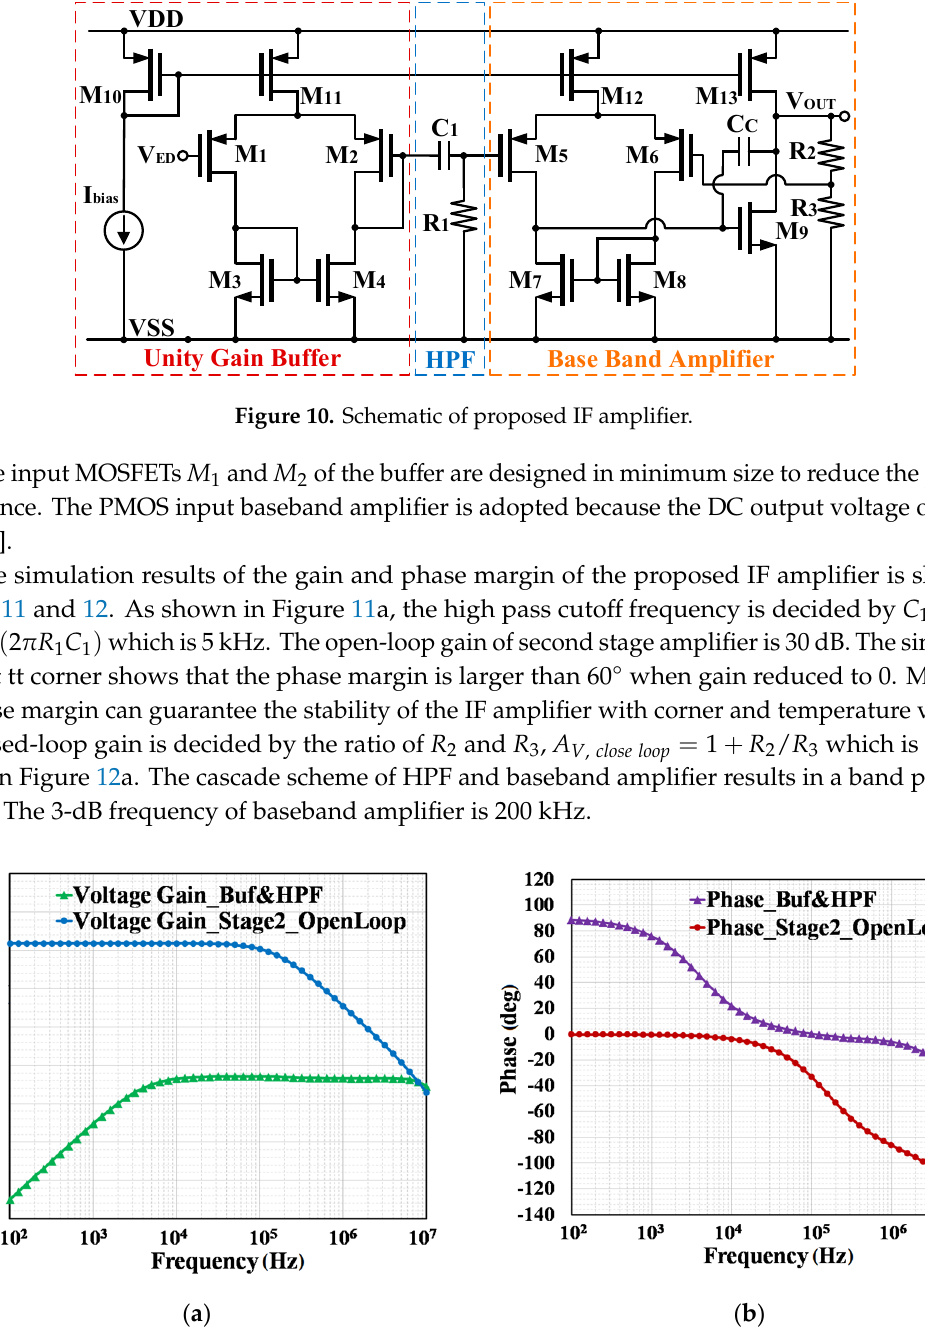
Figure 11. Simulation results of first stage and second stage in IF amplifier: ( a ) gain; ( b ) phase.